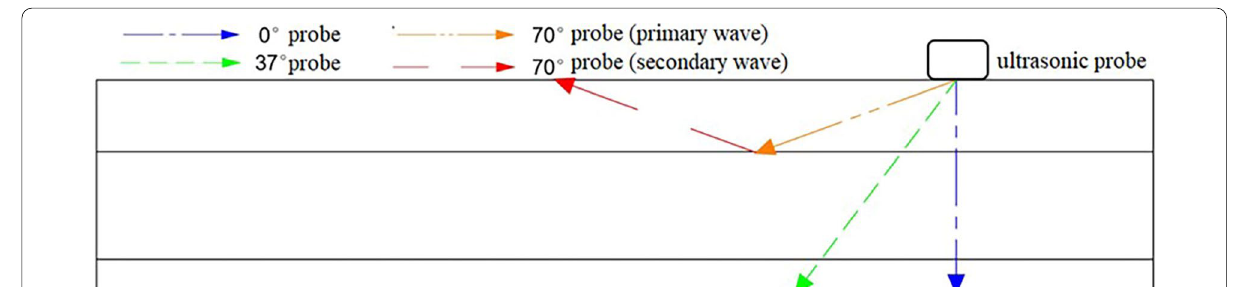
Figure 2 Reflection diagram of ultrasound in railway